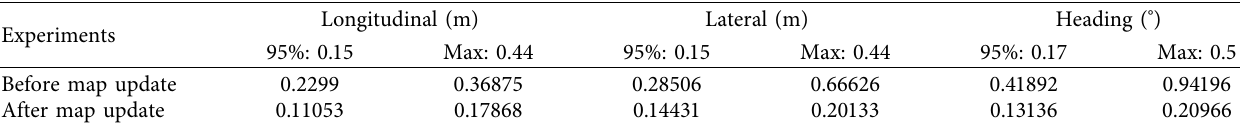
Figure 24: Online localization performance after GND map update. Table 6: Table of localization performance before and after map